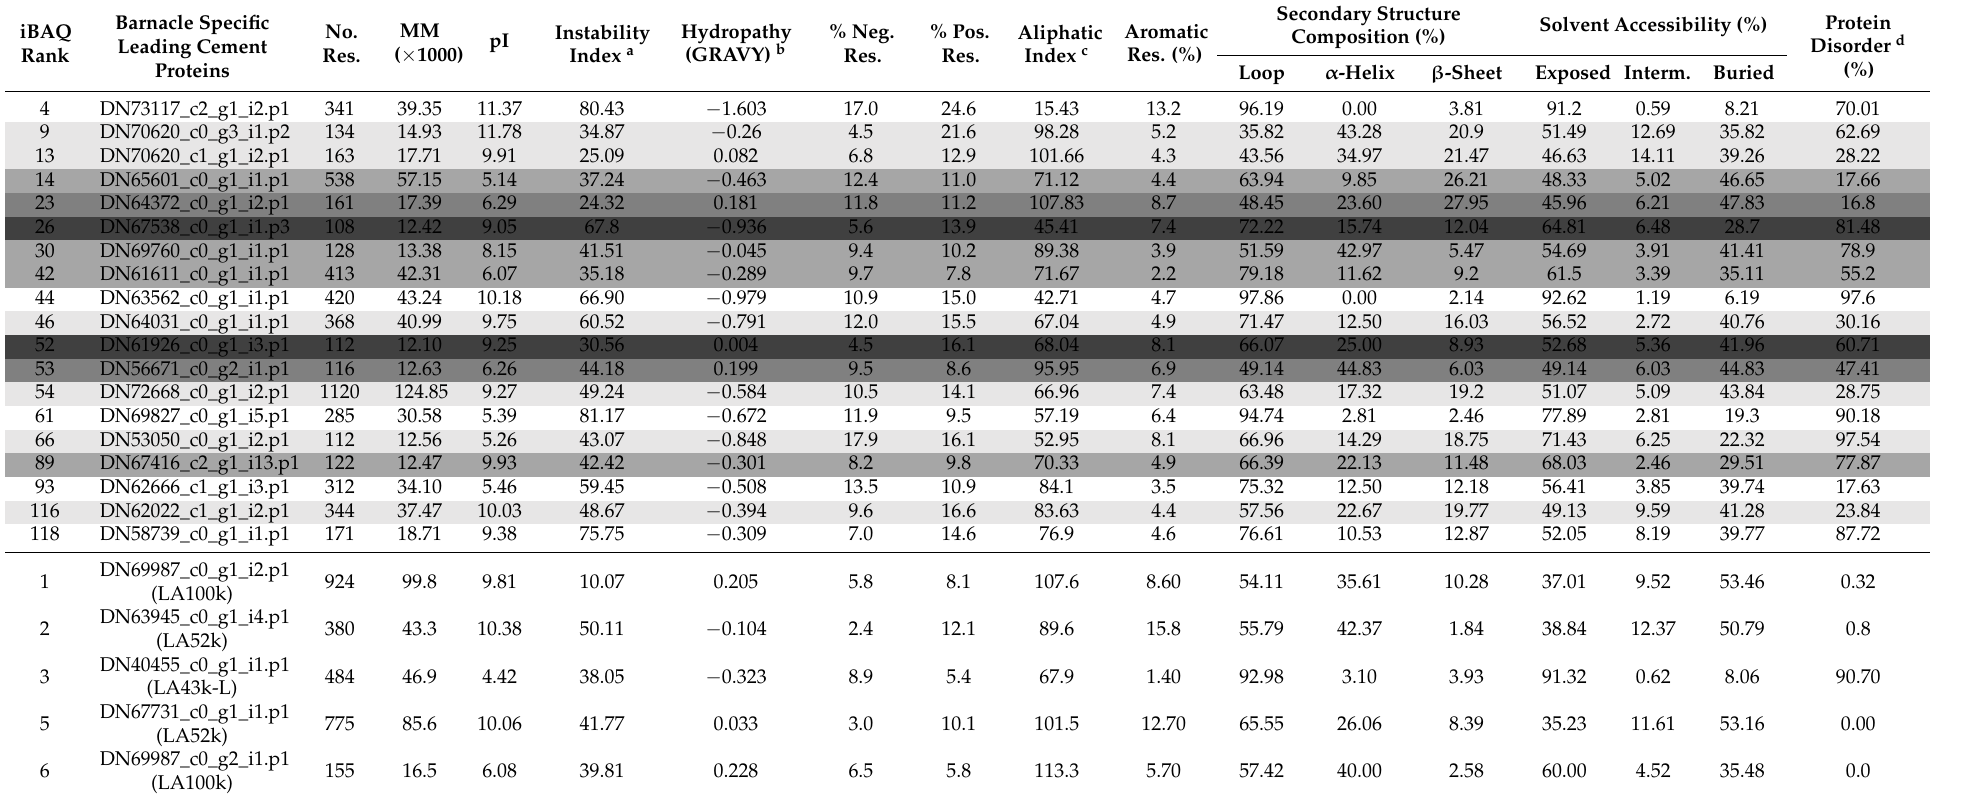
Table 1. Characteristics of the nineteen unannotated proteins (upper part of the table) identified in Lepas anatifera cement proteome through PCA and nine annotated ones (lower part of the table) using automatic adjustment of the BLASTp program through automatic BLAST against the Non-Redundant protein database (nr at NCBI). No. Res—number of residues; MM—molecular mass; pI—isoelectric point; Neg. res.—negative residues (sum of Asp and Glu); Pos. res.—positive residues (sum of Arg, His, and Lys); Incomplete sequence proteins are presented in italic. In very dark grey are the proteins that have clustered with G2 surface coupling proteins of CP20k kind, in dark grey are those that clustered with bulk proteins (G3), in light grey those that have clustered with G1 of surface coupling proteins, and in very light grey are the proteins that cluster with two previously identified CPs in Amphibalanus eburneus : CP7k and -22k. ¥ —protein misannotated as CP-52k-L3, since as it may be seen by PCA analysis (Figure 6), it clusters with surface coupling proteins (G1), and not with bulk proteins